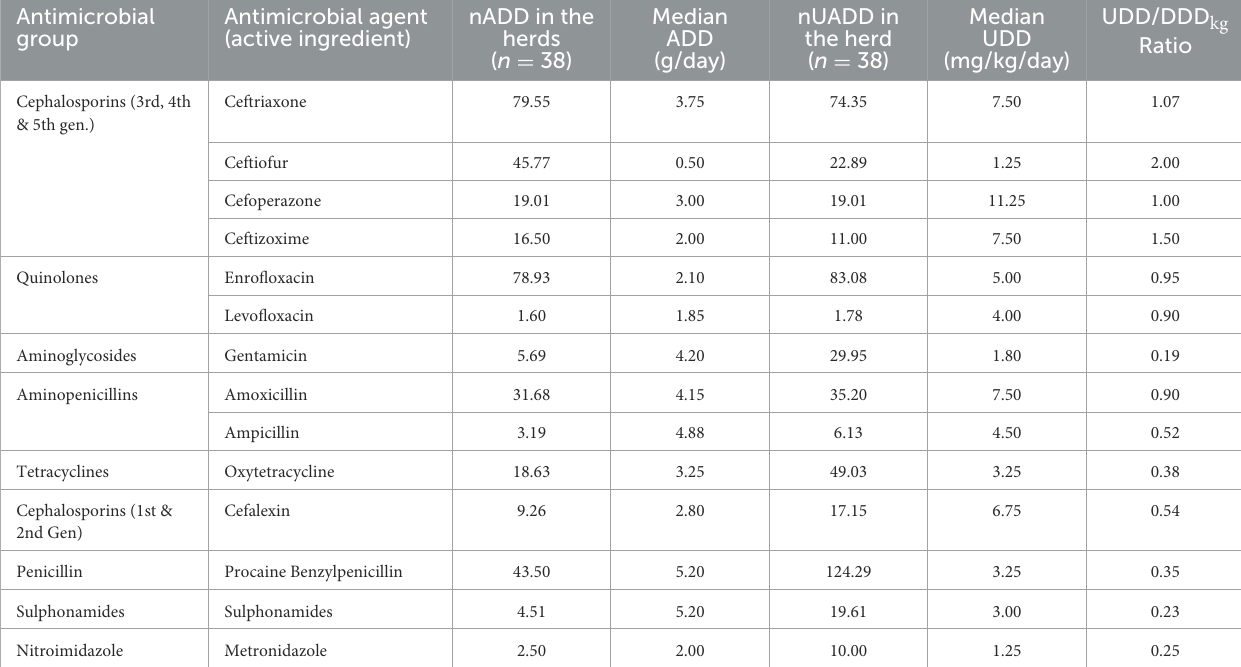
TABLE 3 Number of animal daily doses (nADD), animal daily dose (ADD) (g/day), number of used animal daily doses (nUADD), used daily doses (UDD) (mg/kg/day) and dosing ratio of antimicrobial compounds administered in the study herds. Antimicrobial Antimicrobial agent group (active